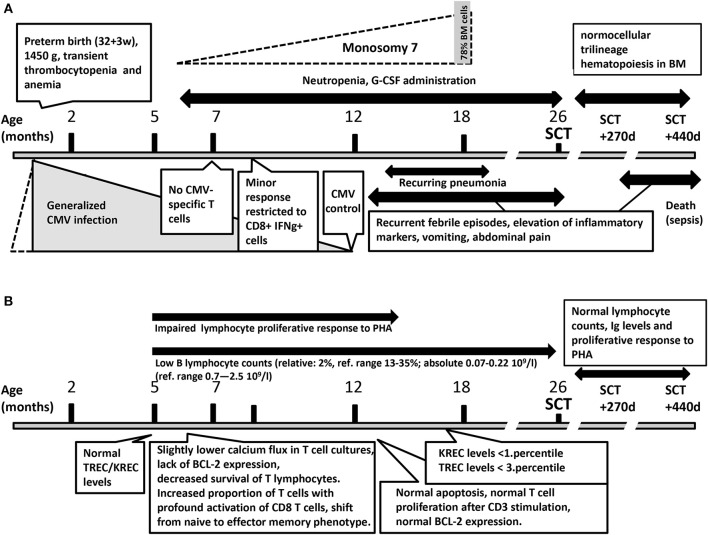
(A) The results of hematological testing and infectious diseases during the course of the disease. (B) The results of immunological testing during the course of the disease. BM, bone marrow; CMV, cytomegalovirus; IFNg, interferon gamma; SCT, hematopoietic stem cell transplantation.